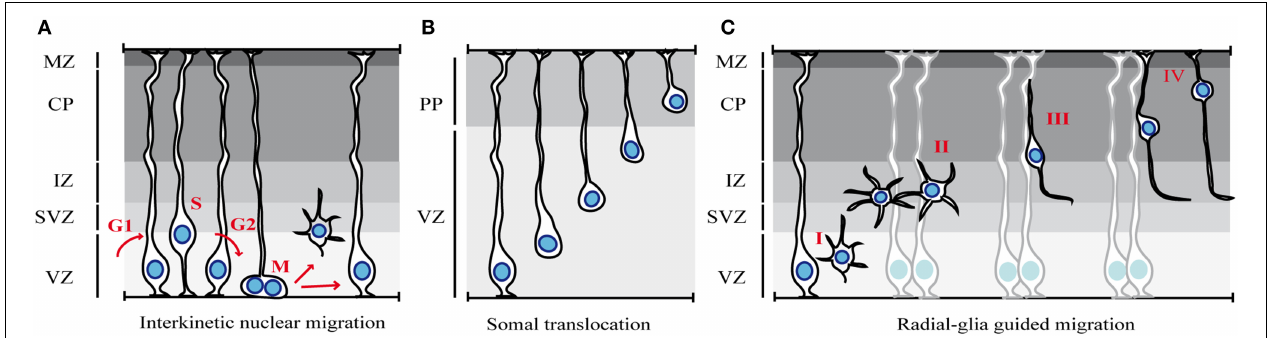
FIGURE 1 | Modes of migration in the cortex. (A) Interkinetic nuclear migration. The nuclei of neuroepithelial cells or radial glia cells occupy different positions along the apical-basal axis depending on the phase of the cell cycle (see text for details). (B) Somal translocation of early-born cortical neurons. Newborn neurons lose their apical attachment and reach the PP by translocation of the soma and progressive shortening of the basal process. (C) Glia-guided radial migration of cortical neurons. Four